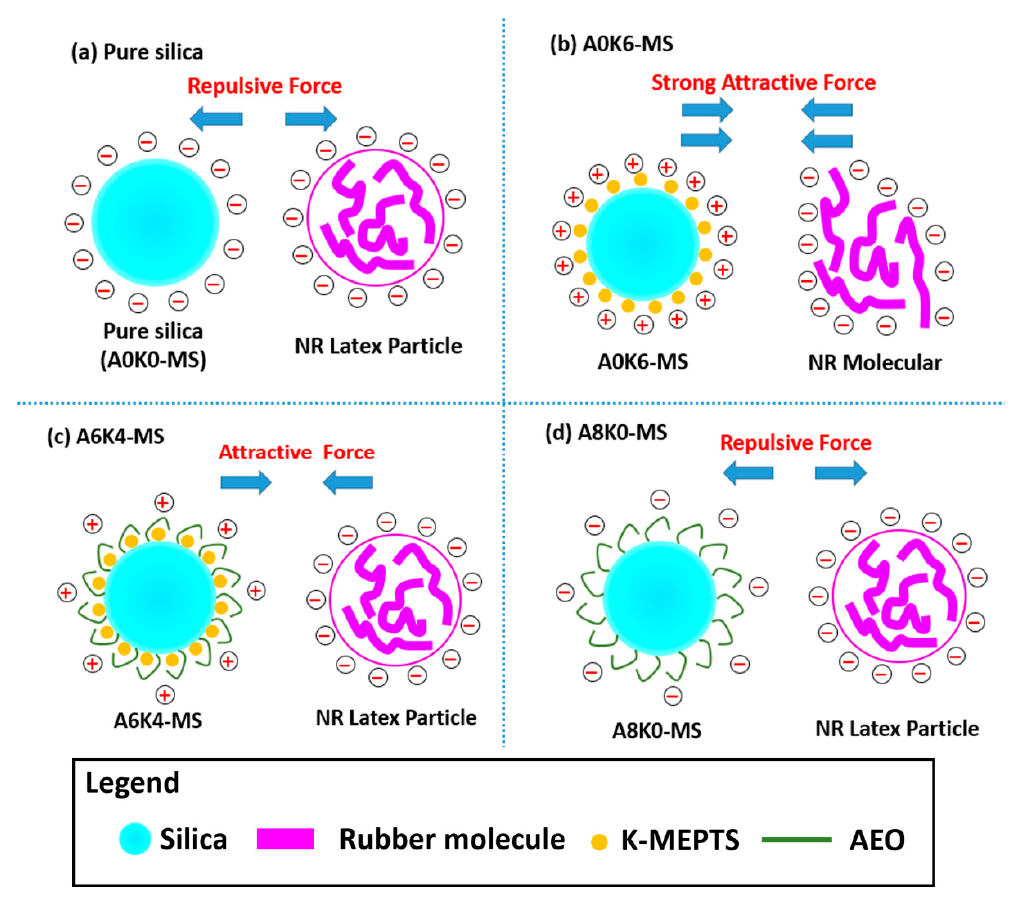
Figure 8. Schematic diagram of the electrostatic forces between pure or modified silica and NR.